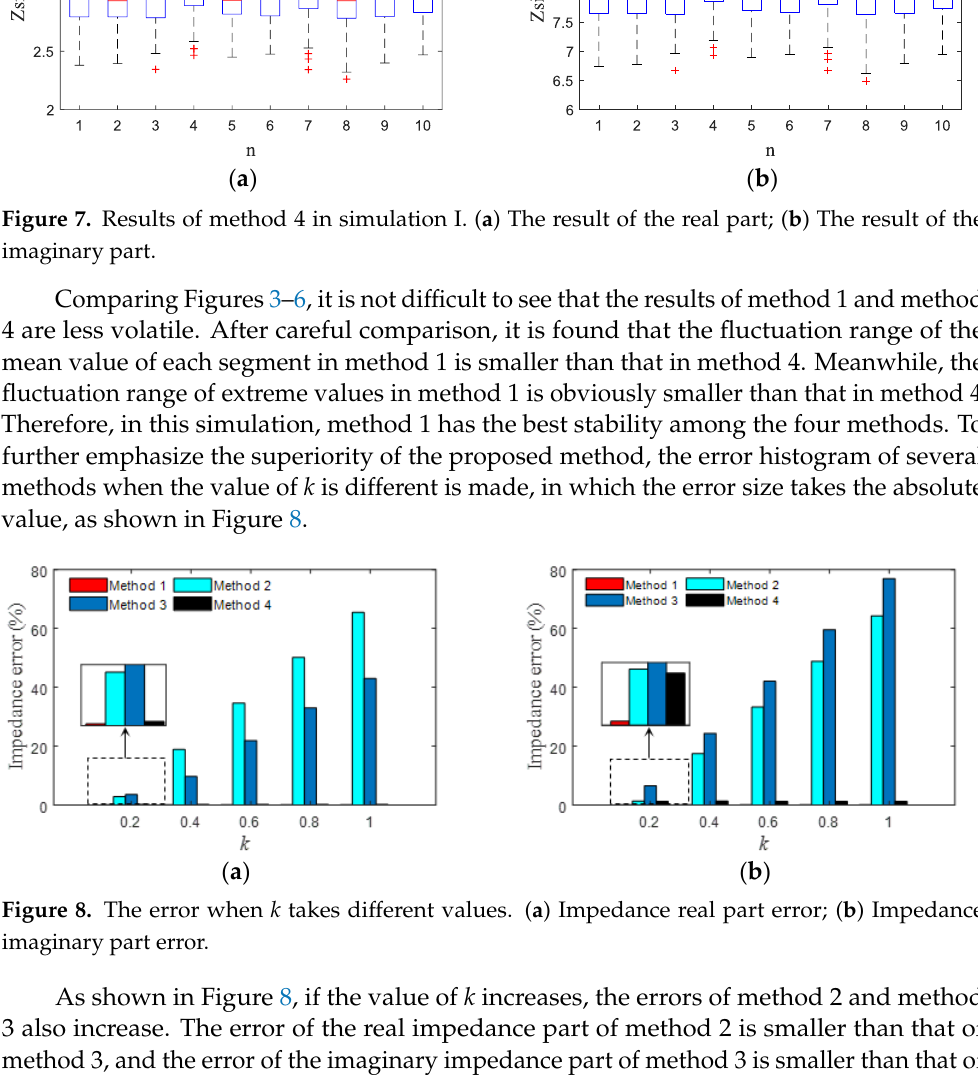
imaginary part error.